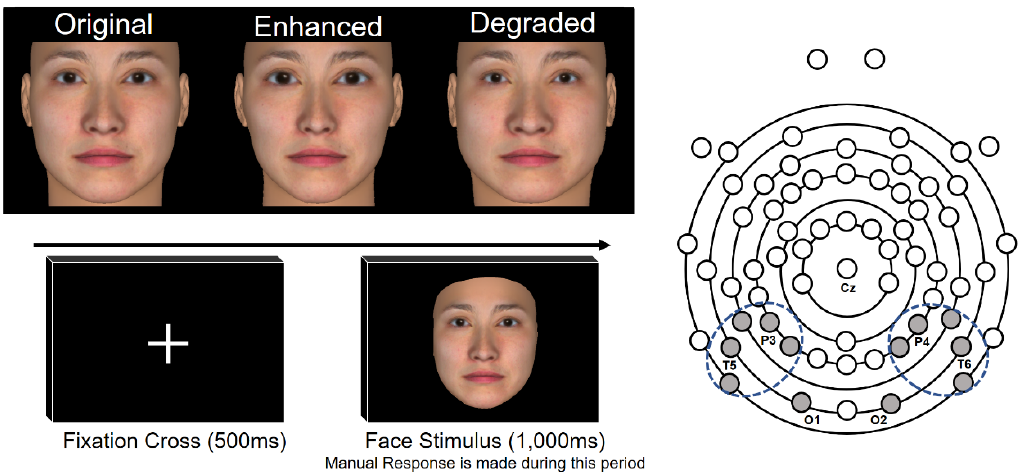
Figure 1. Left Upper panel: Examples of the actual, aesthetically enhanced and degraded images of facial stimuli. These images were created using FaceGen software (Singular Inversions Inc. Tronto, Canada) for demonstration purposes only, and were not used in the actual experiment. Left Lower Panel: Schematic representation of the temporal sequence of a single trial. Right Panel: Representation of channel locations. The sensors used for ERP mean amplitude analyses are filled in grey. Sensors included in each occipito-temporal electrode cluster are circled by blue broken lines.